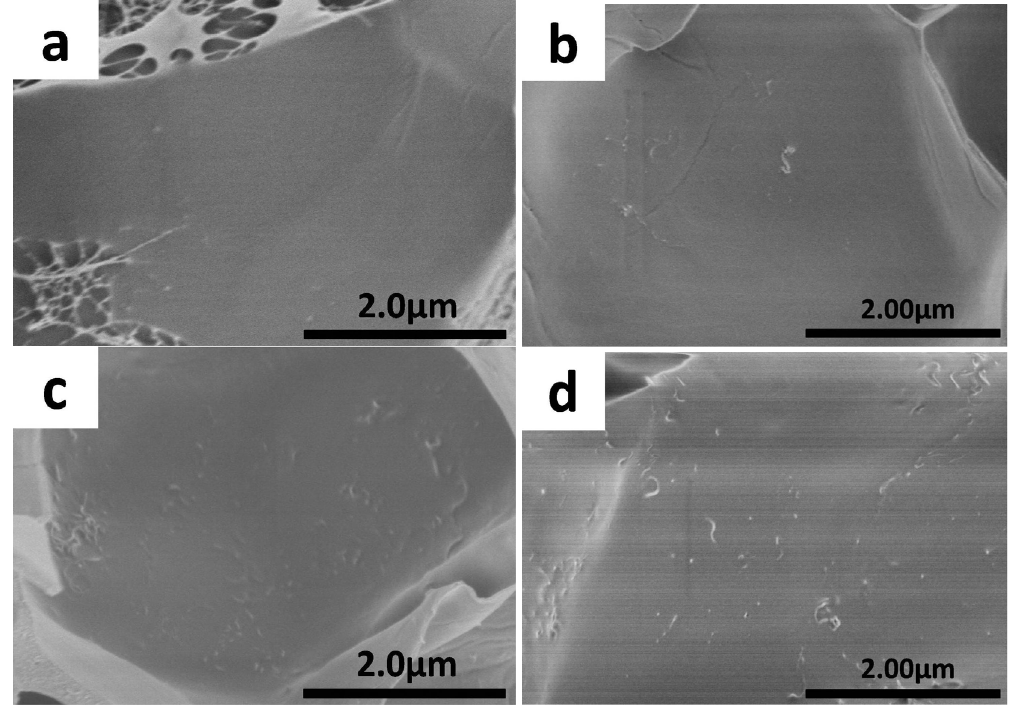
Figure 6. SEM images of pore wall for CNTs-filled nanocomposite hydrogels ( a )